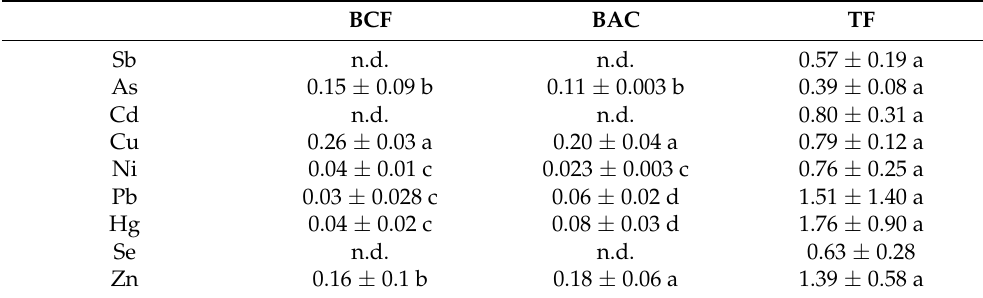
Table 2. Translocation factor (TF), bioconcentration factor (BCF), and bioaccumulation factor (BAC) in Melilotus albus for the respective detected PTEs.